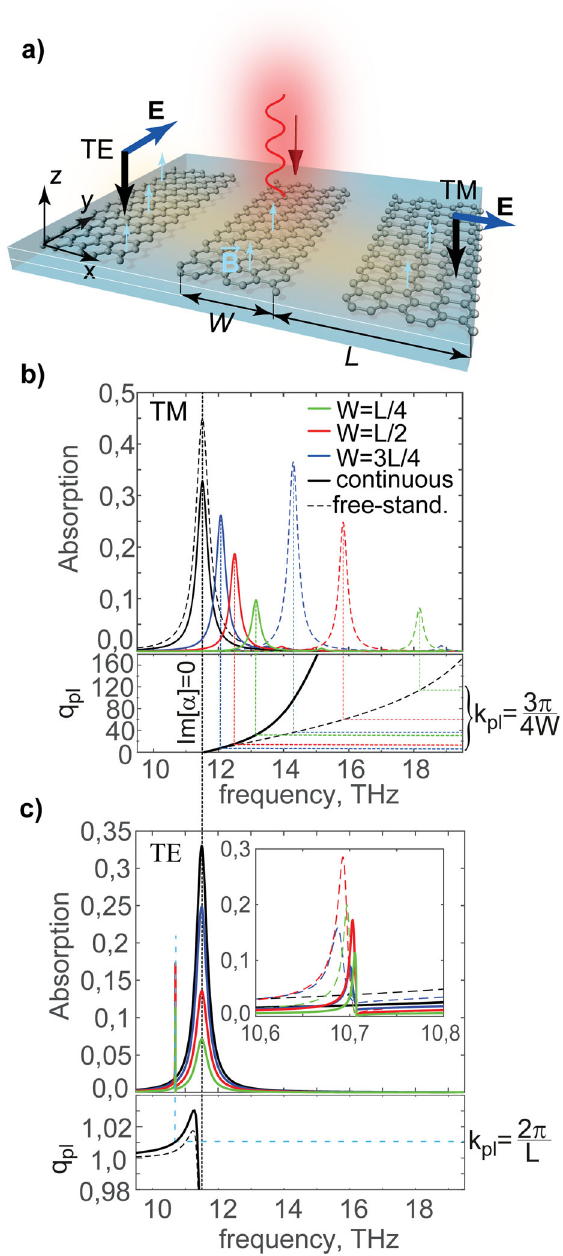
Fig. 5 Excitation of transverse magnetic (TM) and transverse electric (TE) graphene plasmon polaritons (GPPs) in magnetized charge neutral graphene (MCNG) ribbon arrays. a Schematics of the structure. A MCNG ribbon array with the ribbon period L and ribbon width W is encapsulated in the hBN layer shown by blue color. The red arrow shows schematically the direction of an incident plane wave. The thick blue and black arrows correspond to the electric fi eld vector and wavevector of the incident plane wave. b Absorption spectra, A ( v ), of TM polarized light incident onto hBN- encapsulated (solid curves) and free-standing (dashed curves) MCNG ribbon arrays with different ribbon widths, W . The thickness of both top and bottom hBN layers is 10 nm The bottom panel shows the dispersion relation of TM GPP in MCNGs. c The same as in ( b ), but for TE polarized light. The inset in the upper panel shows a zoom of the resonance region. The periods of the ribbon arrays are L = 0.22 μ m and L = 28 μ m for the TM and TE polarizations, respectively. In both cases, the magnetic fi eld is B = 1.3 T